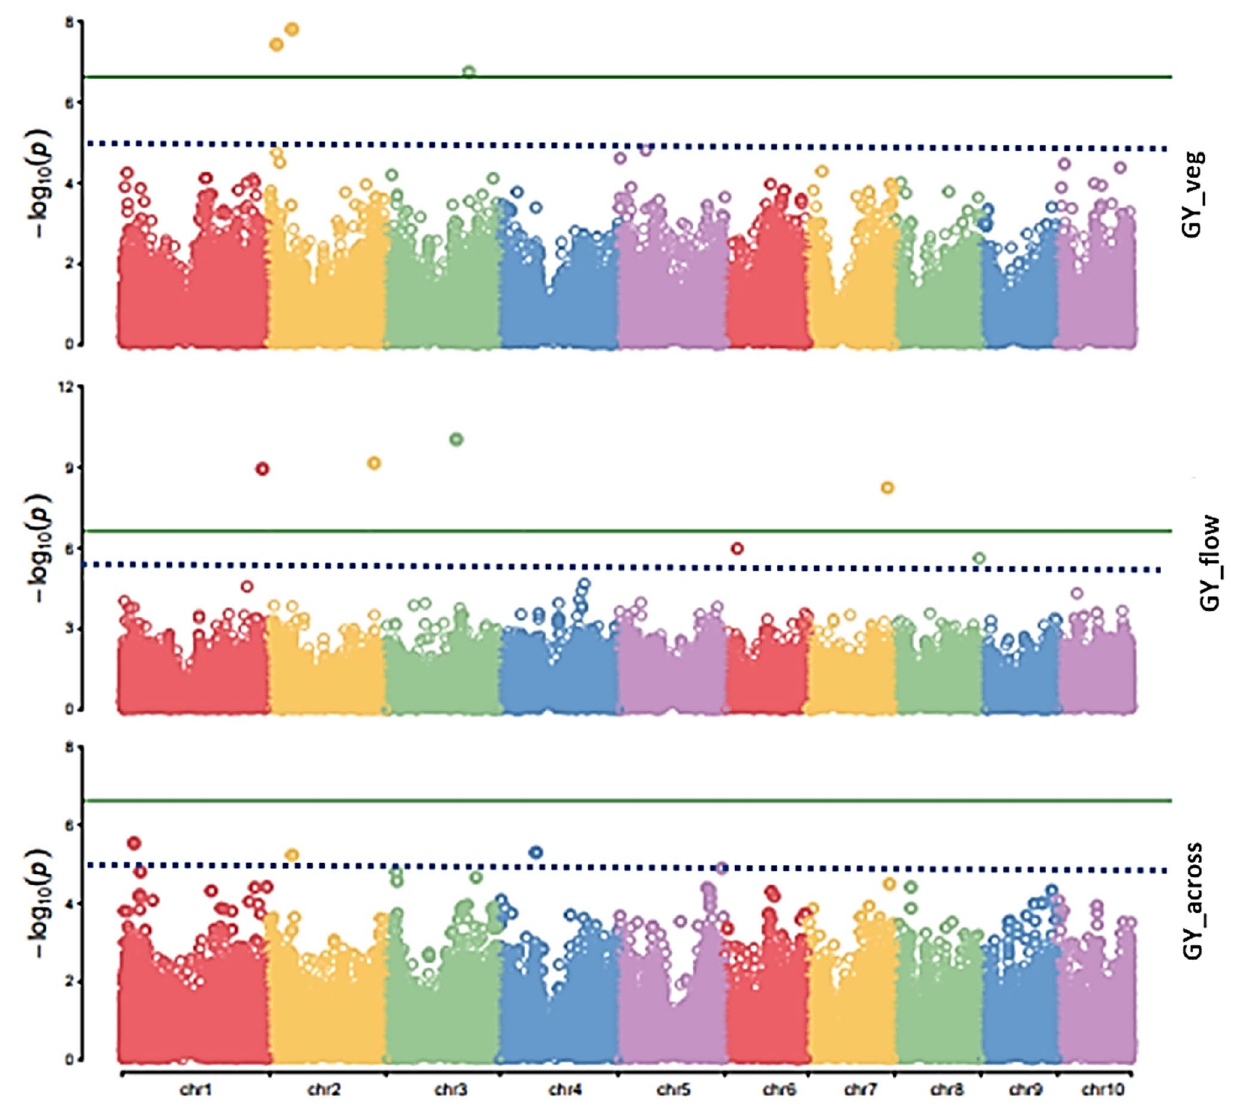
Figure 4. Manhattan plot representing the regions significantly associated with grain yield under vegetative (veg), flowering (flow) and across (across) location